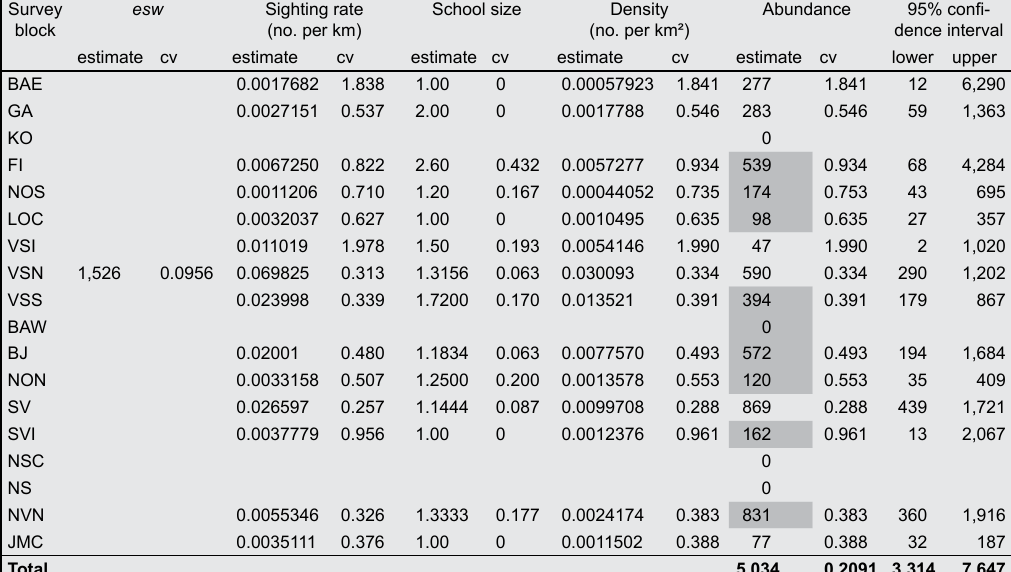
Table 6. Estimated abundance for fin whales for the shipboard survey in 1995, based on the combined data from platforms 1 and 2. Estimates that include single-platform effort are shaded. Survey